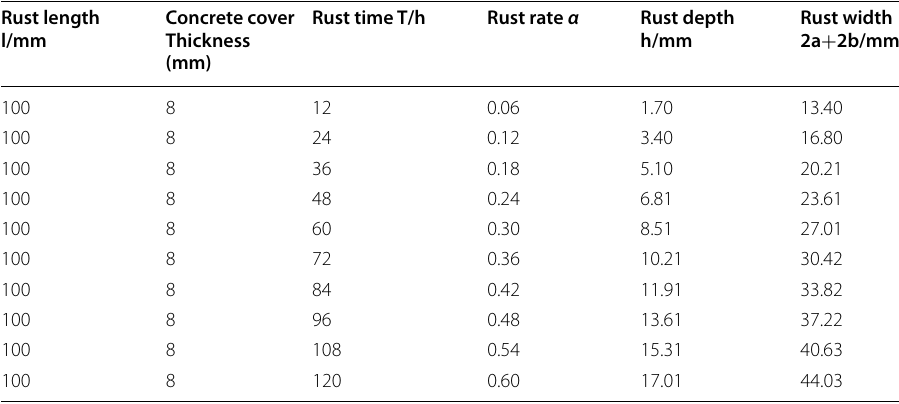
Table 6 16-mm steel bar diameter model parameter settings (mm) Rust length